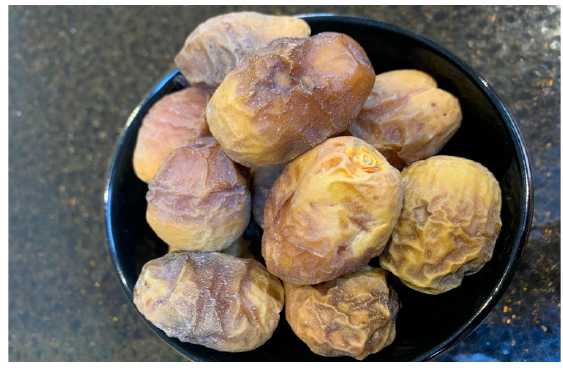
Figure 19. Sample of Soor dates.